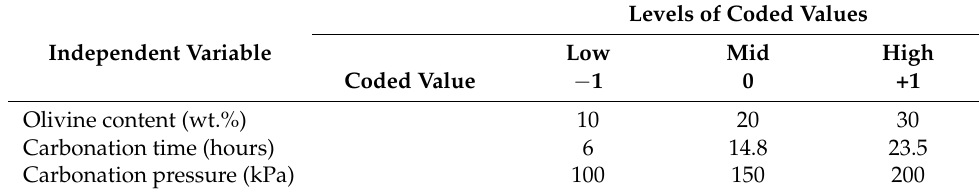
Table 3. Actual and coded values of the independent variables.